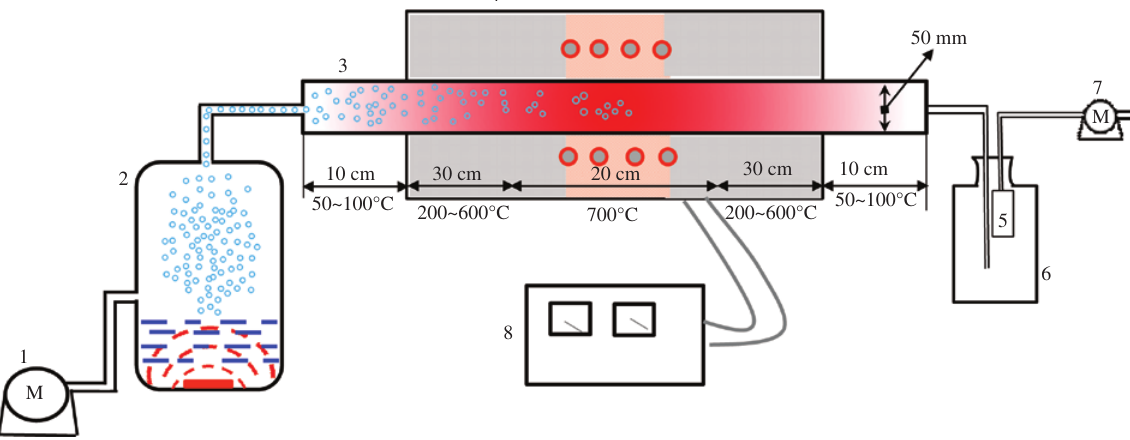
solution at 700 ° C. 3